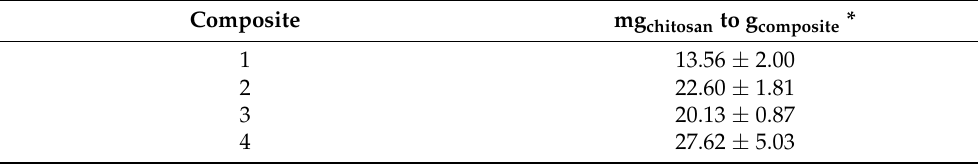
Table 2. Chitosan crosslinked into the composites developed